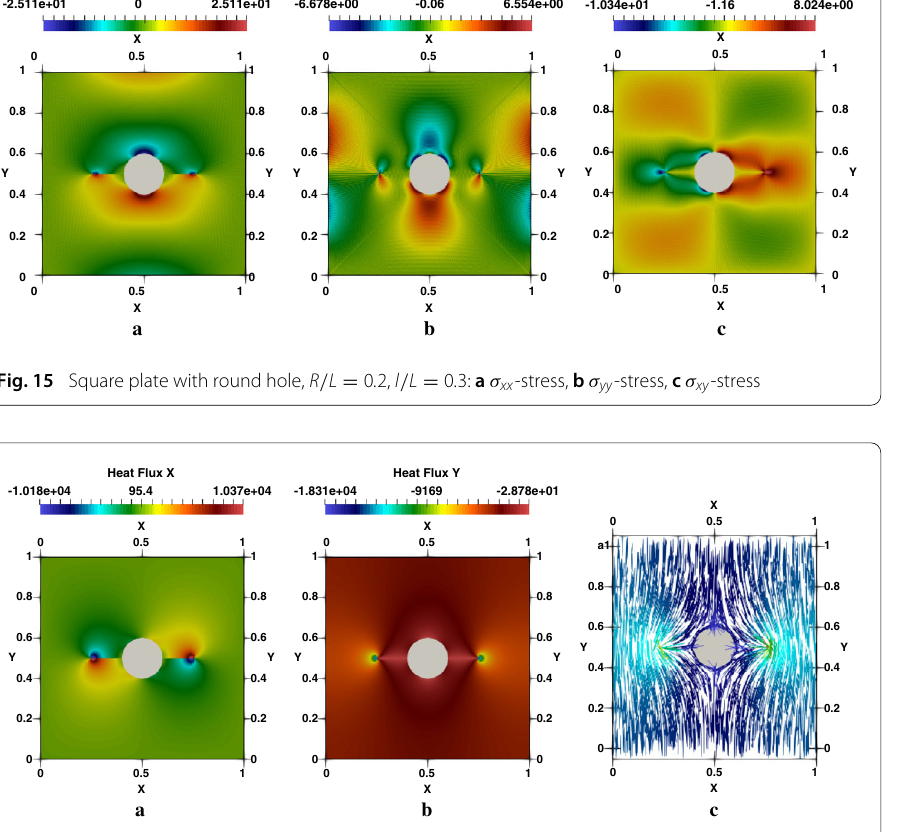
at the bottom, and top edges excepted both the bottom and top right corners where the plate is embedded. The two top and bottom sides are considered insulated, i.e., the heat flux q is zero; a prescribed temperatures of ± (cid:20) 0 are imposed at the right and left boards, such (cid:20) 0 = 10 ◦ C in Fig. 17a. Crack geometry and the structured rectangular uniform mesh of 30 elements upon the width and 120 across the height is shown in